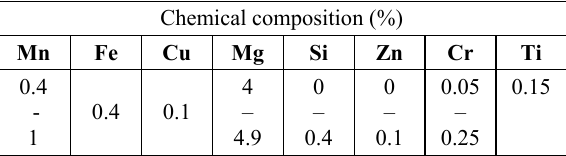
Table 1. Workpiece material alloyed elements